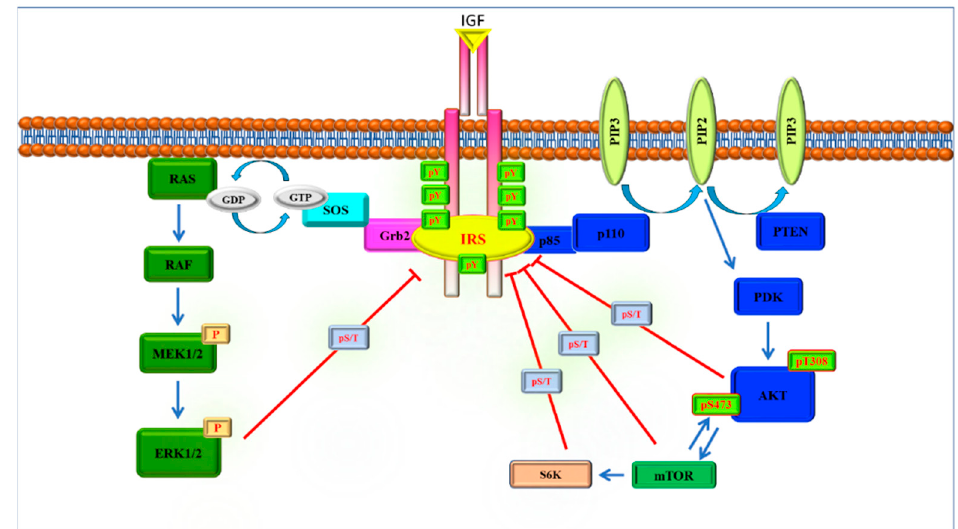
Figure 1. Canonical IRS signaling pathway adapted from [24]. IRS proteins mainly induce the activations of the PI3K-AKT and MAPK pathways. After the binding of receptor tyrosine kinases, IRS proteins are phosphorylated by their tyrosine residues and this activation triggers the IRS-induced signaling pathways. Activations of IRS proteins are regulated through Ser/Thr phosphorylations as a feedback mechanism of their downstream targets.